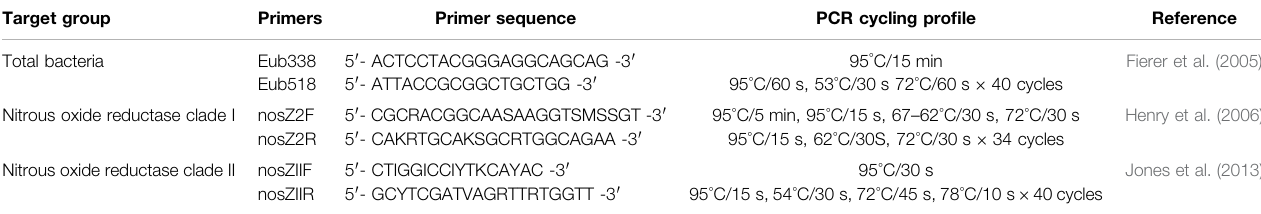
TABLE 1 | Quantitative polymerase chain reaction (qPCR) primers and cycling pro fi les for total bacterial abundance and nitrous oxide reductase clade I and II. Target